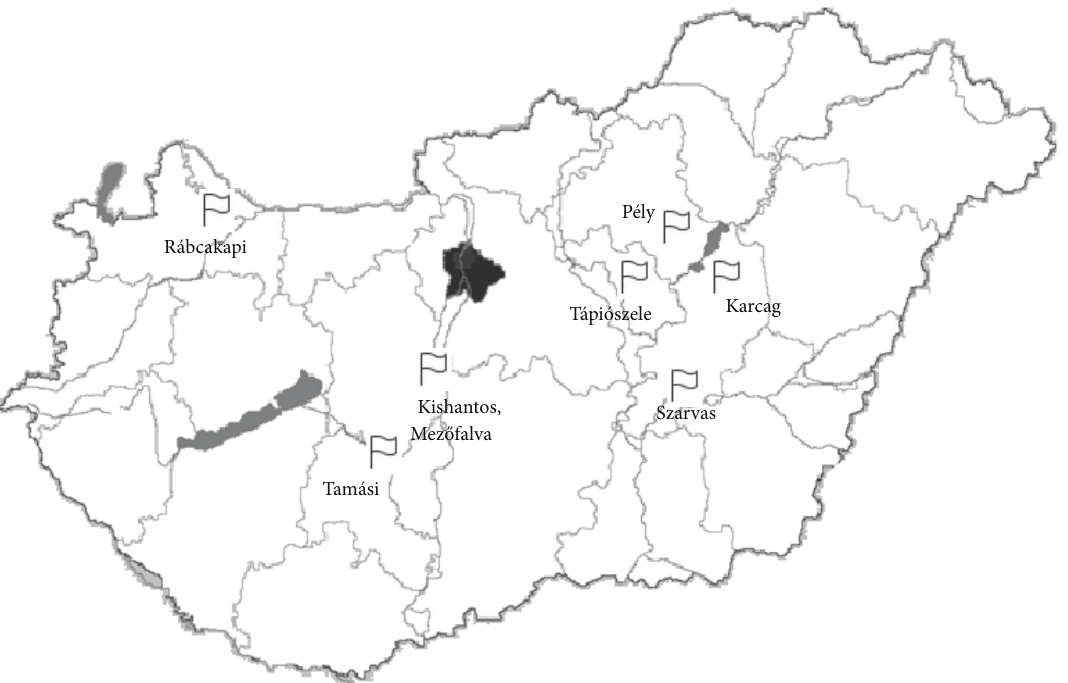
Figure 2: Surface water sampling sites near fields of ecological (organic) agricultural production